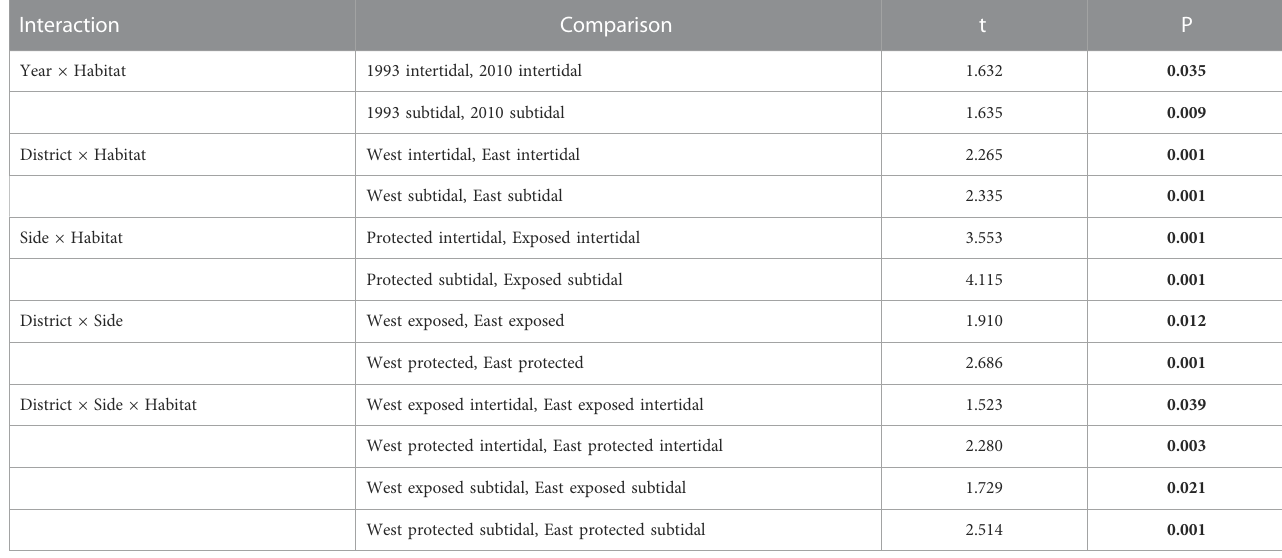
TABLE 3 Pairwise t-tests between factor levels of interest for signi fi cant interactions within the Hierarchical Nested Mixed Model PERMANOVA (Number of permutations = 998 – 999). Bold – p < 0.05. Interaction